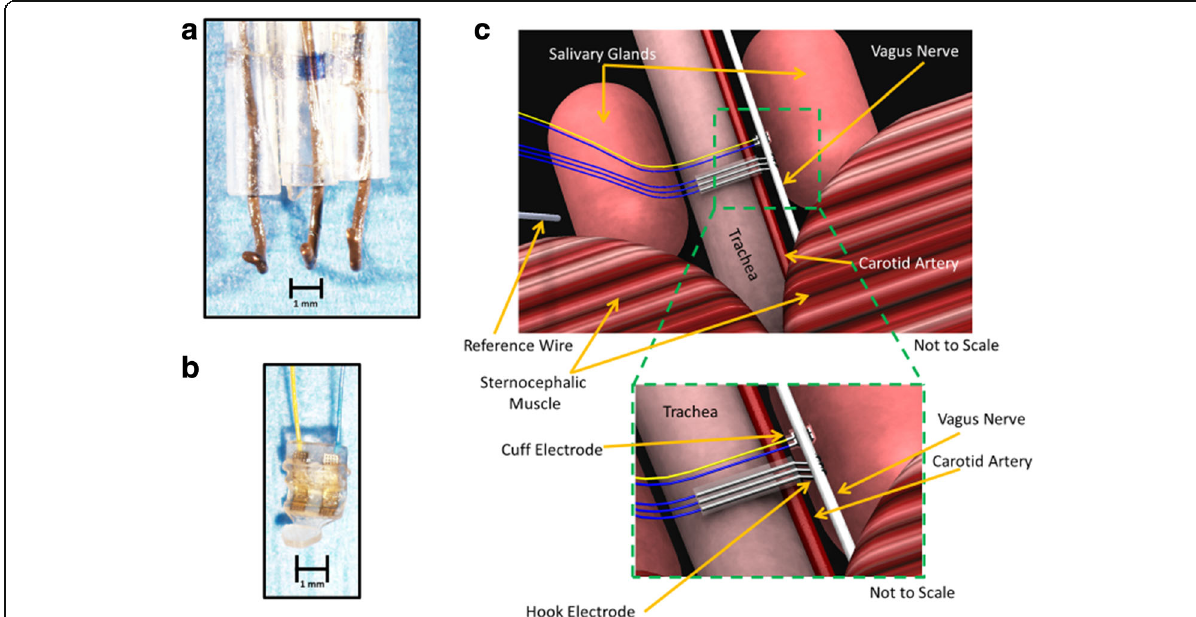
Fig. 1 Electrophysiological recording system for the cervical vagus nerve. a Lab-made hook electrode with three leads was used to record cervical vagus nerve activity. b A cuff electrode purchased from Cortec was used to record cervical vagus nerve activity. c Artist rendering of isolated cervical vagus nerve (not to